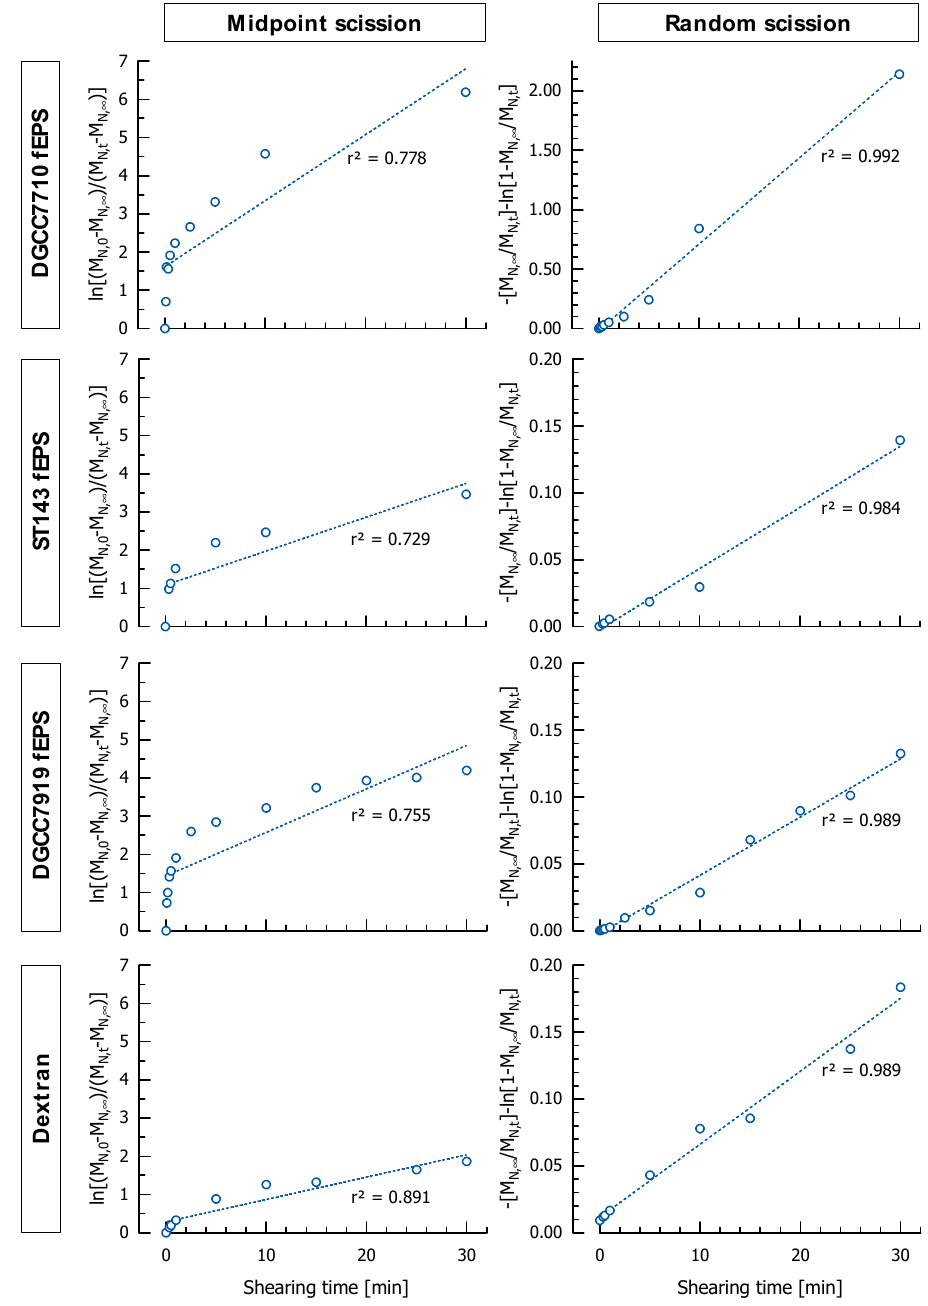
Figure 6. Linearization plot of the midpoint scission model (Equation (2)) and the random scission model (Equation (1)) for ultrasonicated EPS (power density: 114 W/cm²).